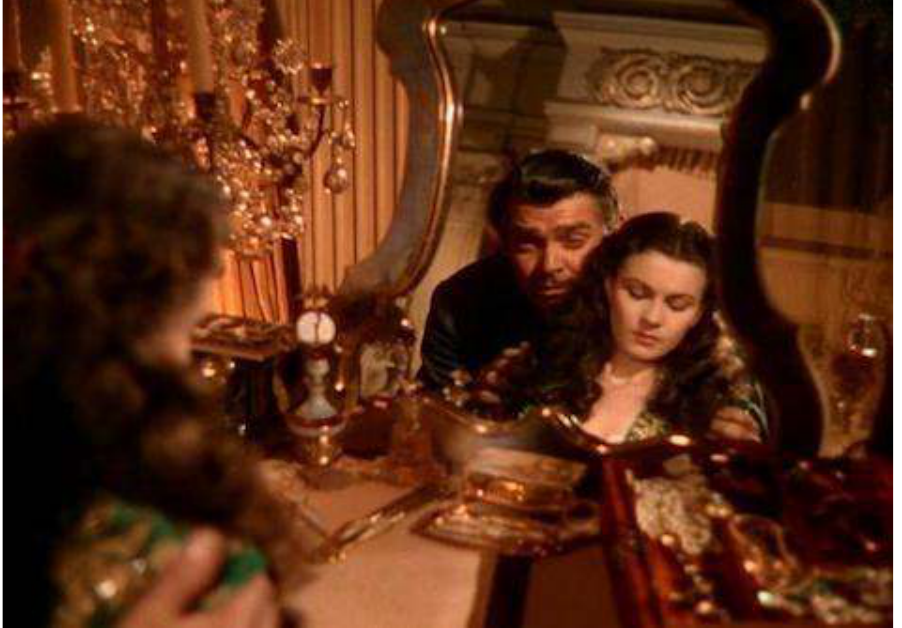
Figure 24: Scarlett refusing Rhett’s kisses in Gone with the Wind